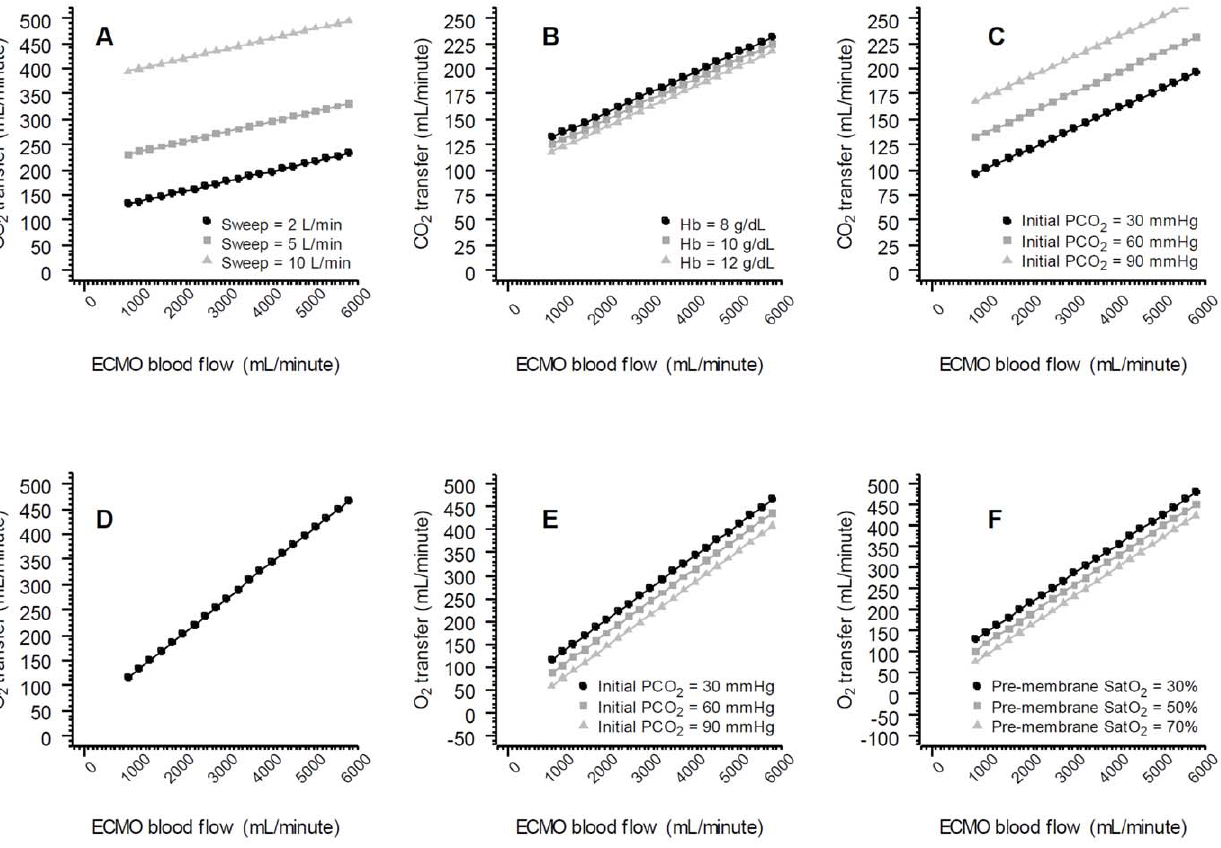
Figure 3. Mathematical marginal model exploring the O 2 and CO 2 transfers according to the progressive elevation of ECMO blood flow. The default variables were: sweep flow=2 L/minute, initial pre-membrane SatO 2 =30%, initial pre-membrane PCO 2 =30 mmHg and initial hemoglobin=8.0 g/dL. The marginal model is derived from the multivariate mixed model. Panel A shows the CO 2 transference resultant from sweep flow variation. Panel B shows the CO 2 transference resultant from hemoglobin variation. Panel C shows the CO 2 transference according to the initial PCO 2 variation. Panel D shows the O 2 transference resultant from ECMO blood flow variation. Panel E shows the O 2 transference resultant from initial PCO 2 variation. Panel F shows the O 2 transference according to the initial pre-membrane SatO 2 value.